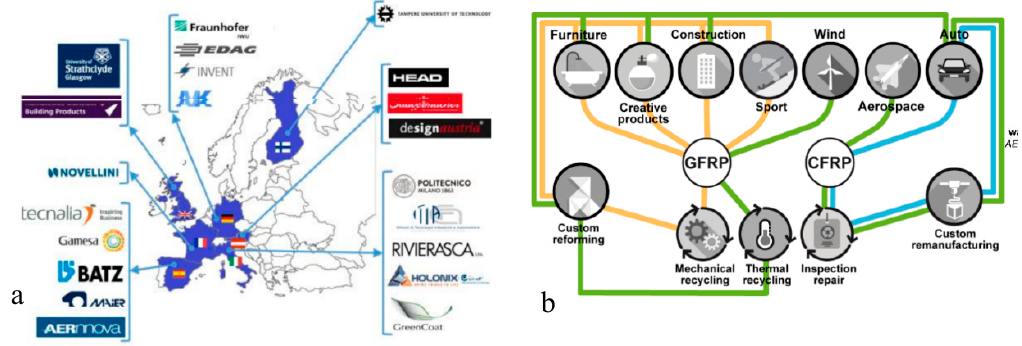
Figure 1. FiberEUse Consortium ( a ); FiberEUse use cases ( b